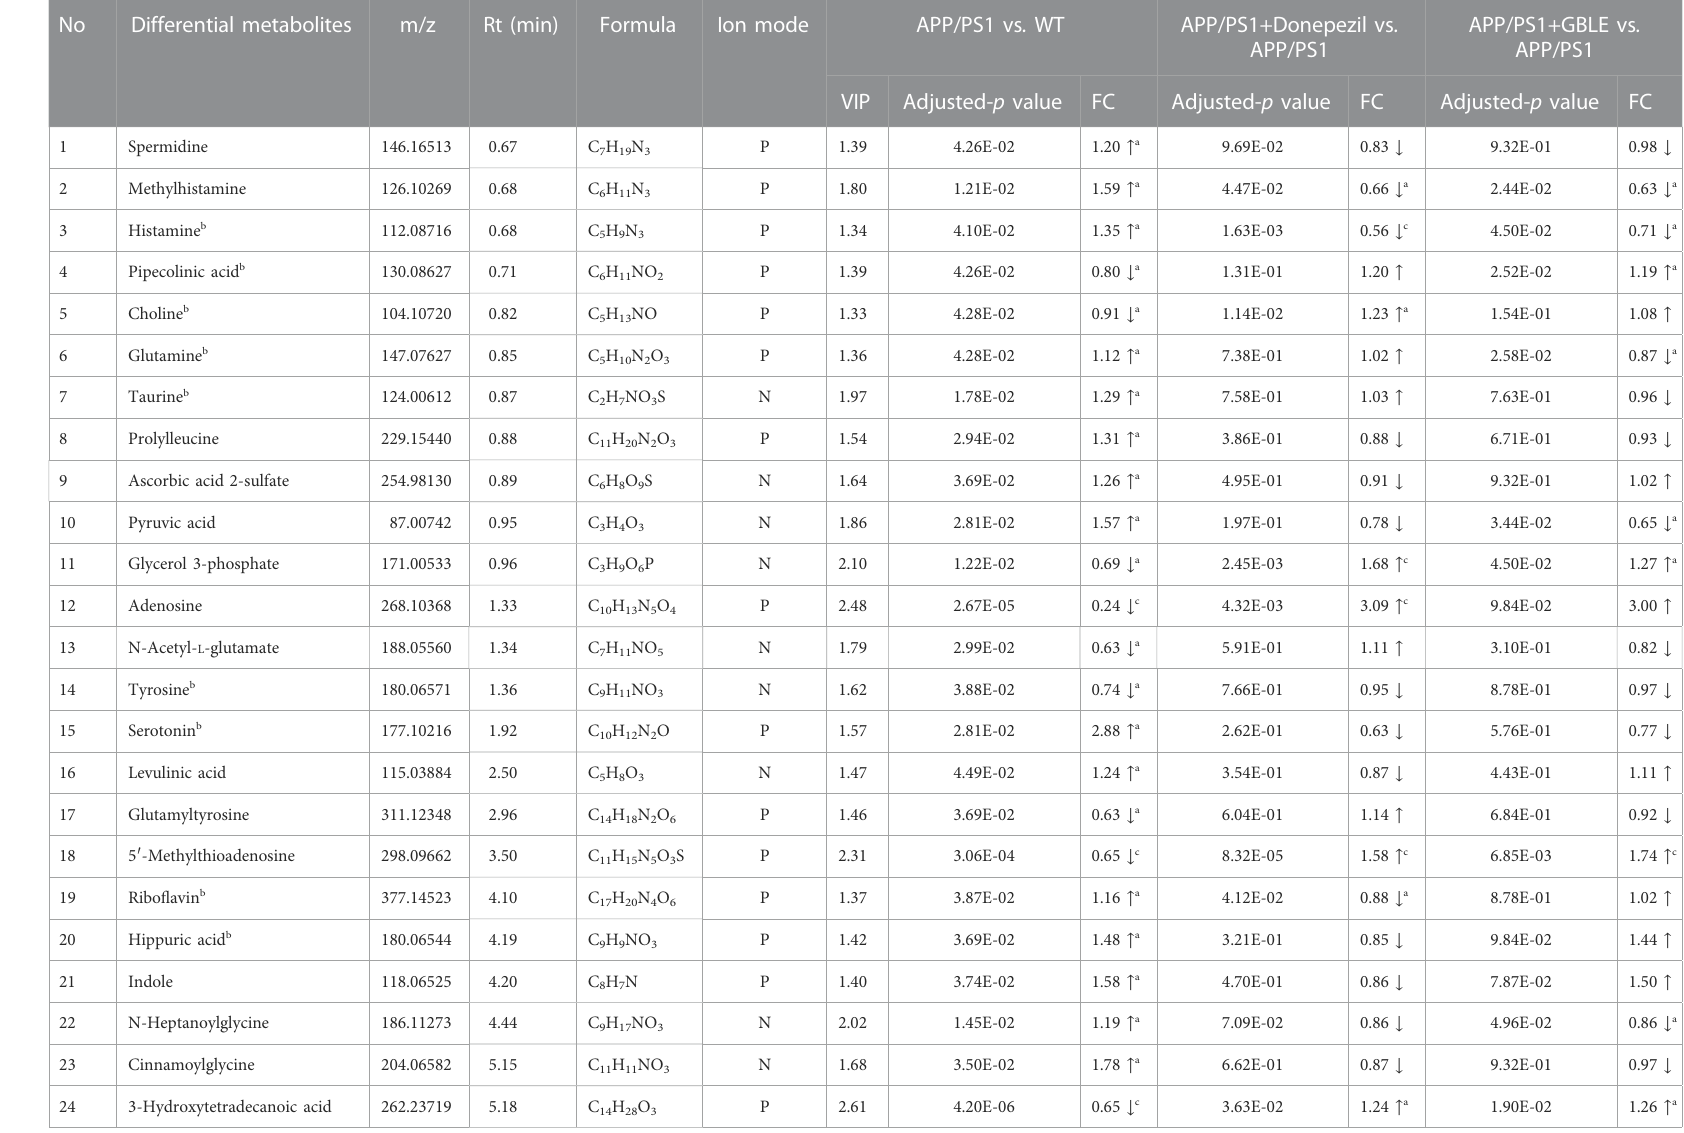
TABLE 1 Differential metabolites between the comparison of APP/PS1 and WT groups and the change trends in response to GBLE treatment.